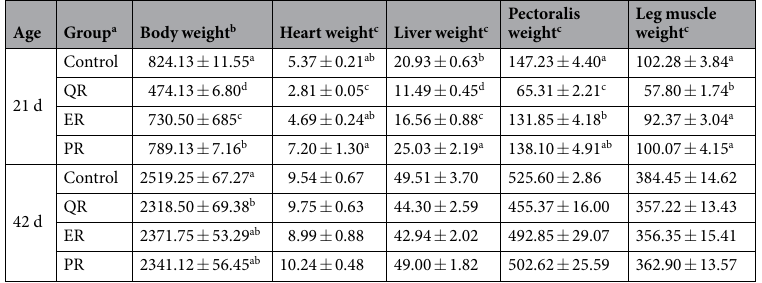
Table 1. Effects of feed restriction on the body weight and tissue weight of broilers (unit: g). Note: a-d different lowercase letters in different groups of the same age indicate P < 0.05. a In 8–21 d, the control group was fed a conventional diet ad libitum, the QR group was fed a conventional diet between 8:00–13:00, the ER group was fed a 15% energy-restricted diet, and the PR group was fed a 15% protein-limited diet. At 22–42 d, the four groups of broilers were transferred to the same conventional diet ad libitum. b Body weight refers to the average live weight of each group of broilers (n = 20). c Tissue weight refers to the tissue weight of the slaughtered broilers (n =